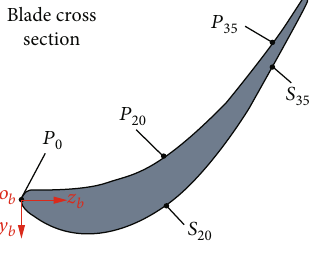
Figure 16: Di ff erent positions to add the surface